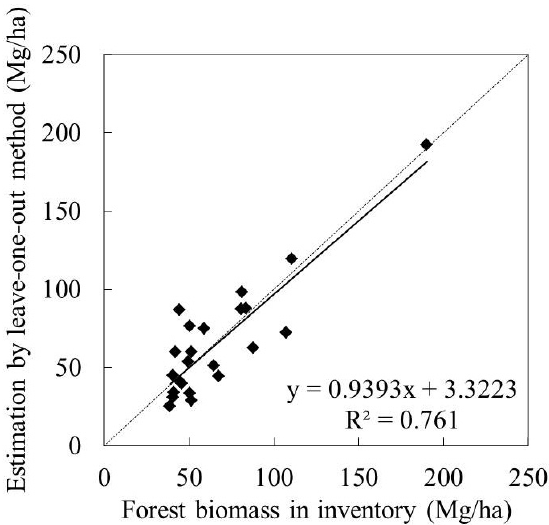
Figure 8. The relationship between average forest biomass using leave-one-out method and that using